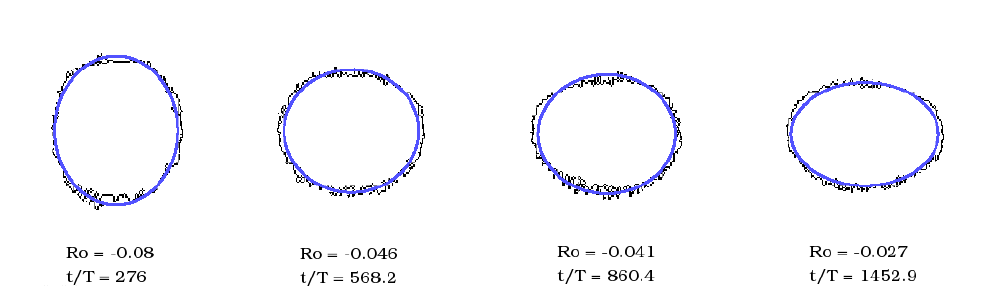
Figure 6. Image-processed side-view boundaries of a vortex sustained with continuous injection at di ff erent times. The flow has f = 1 . 62 rad / s, ¯ N = 2 . 3 rad / s, and an injection rate of 10 mL / min. Also shown are the theoretical boundaries of the model vortices. Line colors are as in figure 5. Unlike the vortex in figure 5, the vortex volume V changes in time. Ro , V , and time t are given for each